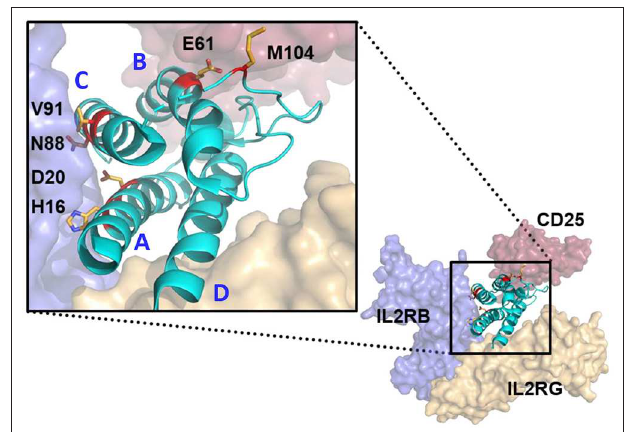
FIGURE 1 | Structure modeling of huIL-2:huIL-2 trimeric receptor complex and the amino acid residues mutated to attenuate the interaction with the various receptor chains. Model was generated from Pymol based on 2B5I pdb of the IL-2 co-crystal structure. CD25, IL2RB, and IL2RG are displayed as red, blue, and gold, respectively. IL-2 ligand is represented in Cyan with residues mutated in the study with side chains displayed and colored in red. Helices (A–D) are indicated in blue. IL-2 mutations that attenuate IL2RB are surface exposed residues which directly contact